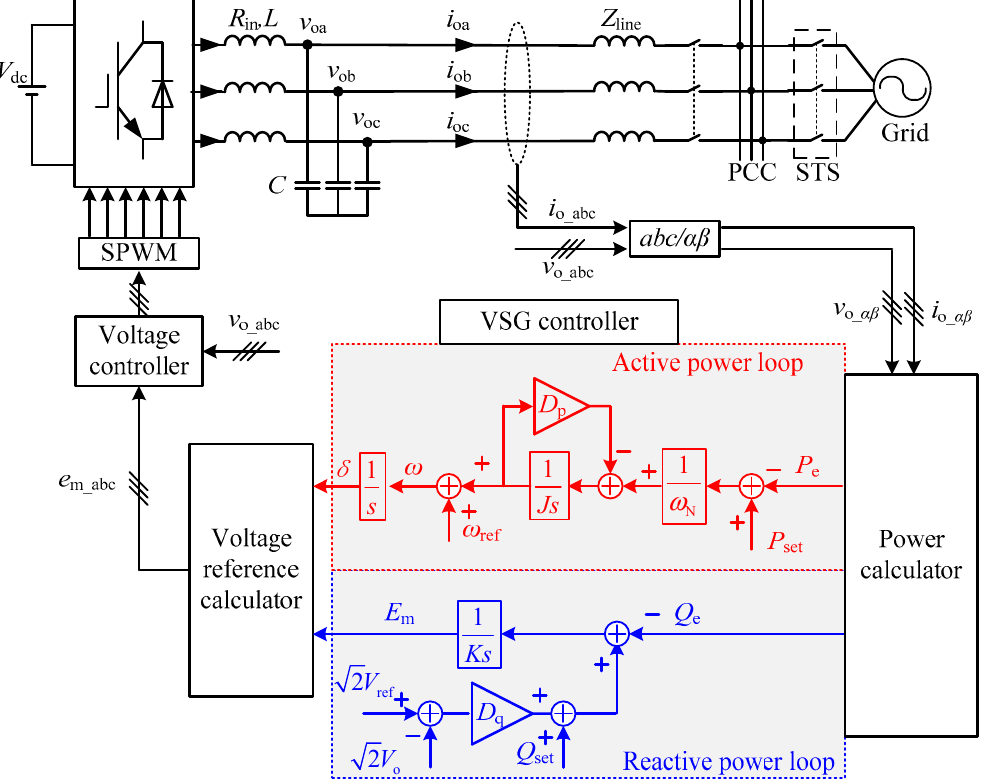
Figure 1. Control diagram of the inverter based on virtual synchronous generator (VSG).